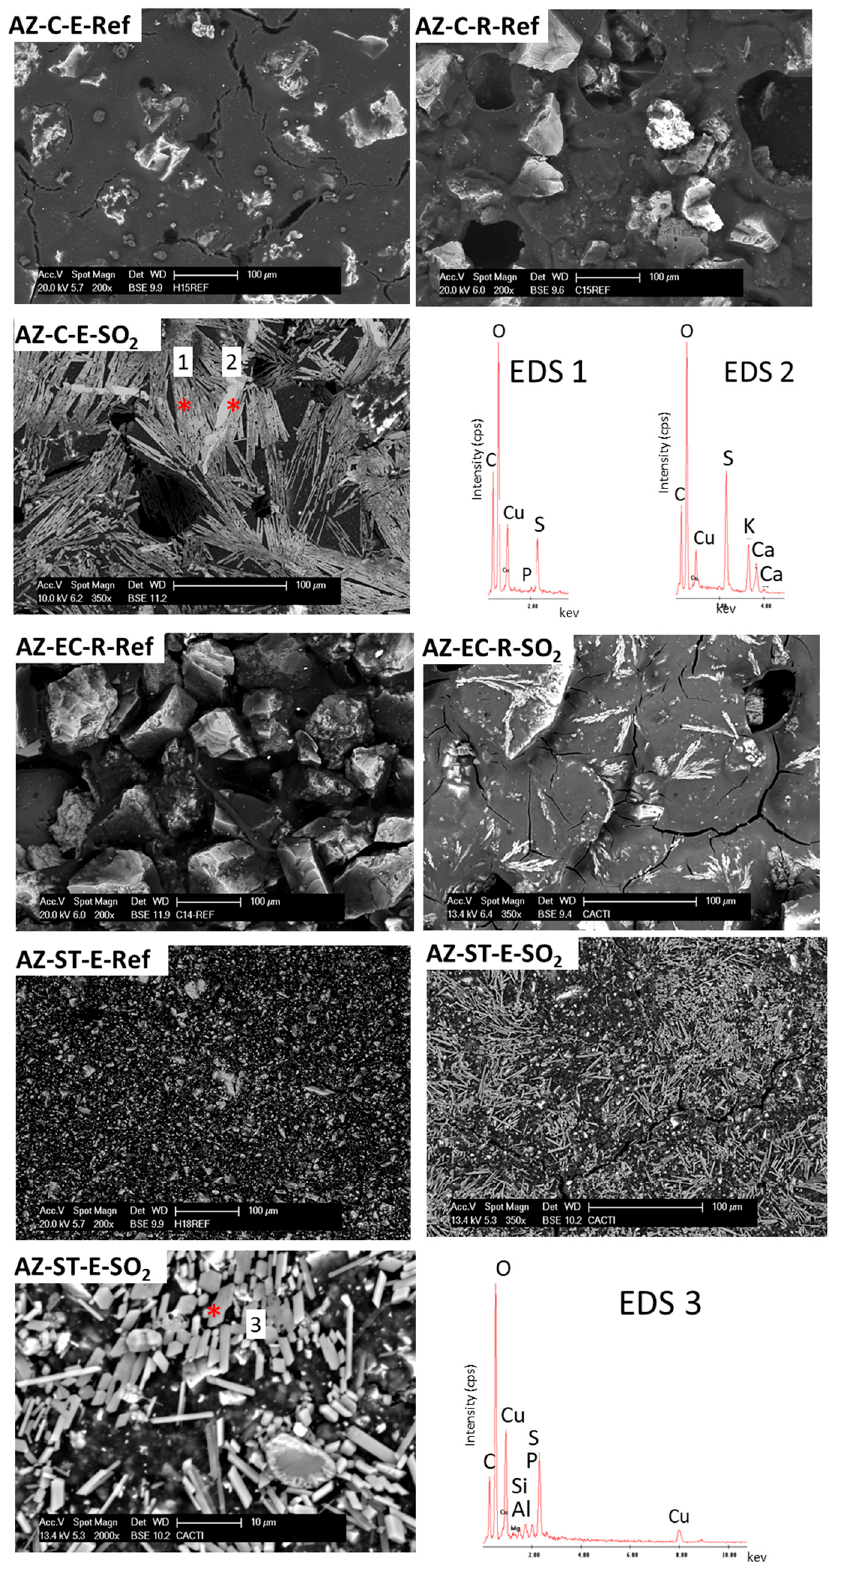
Figure 6. SEM micrographs of reference (Ref) and aged (SO 2 ) paint mock-ups made with azurite (AZ-ST, AZ-EC, AZ-C) mixed with egg yolk (E) or rabbit glue (R). Some of the micrographs are accompanied by EDS spectra (depicted through the number EDS). See Table 1 for the labeling of the paint mock-ups.